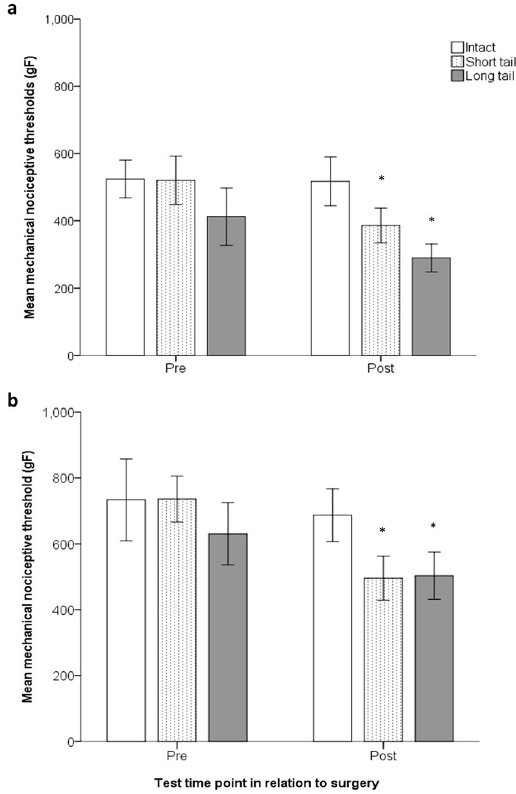
Figure 1. Acute sensitisation one week post-surgery. Mechanical nociceptive thresholds (mean ± SEM) recorded at the site of tail resection 3 days pre- and 1 week post-surgery in pigs undergoing sham/tail amputation surgery (Sham surgery = intact; 2/3rds removed = short tail; 1/3rd removed = long tail) at ( a ) 9 and ( b ) 17 weeks of age. Asterisks indicate significant difference (P < 0.05) between MNTs collected pre- vs. post-